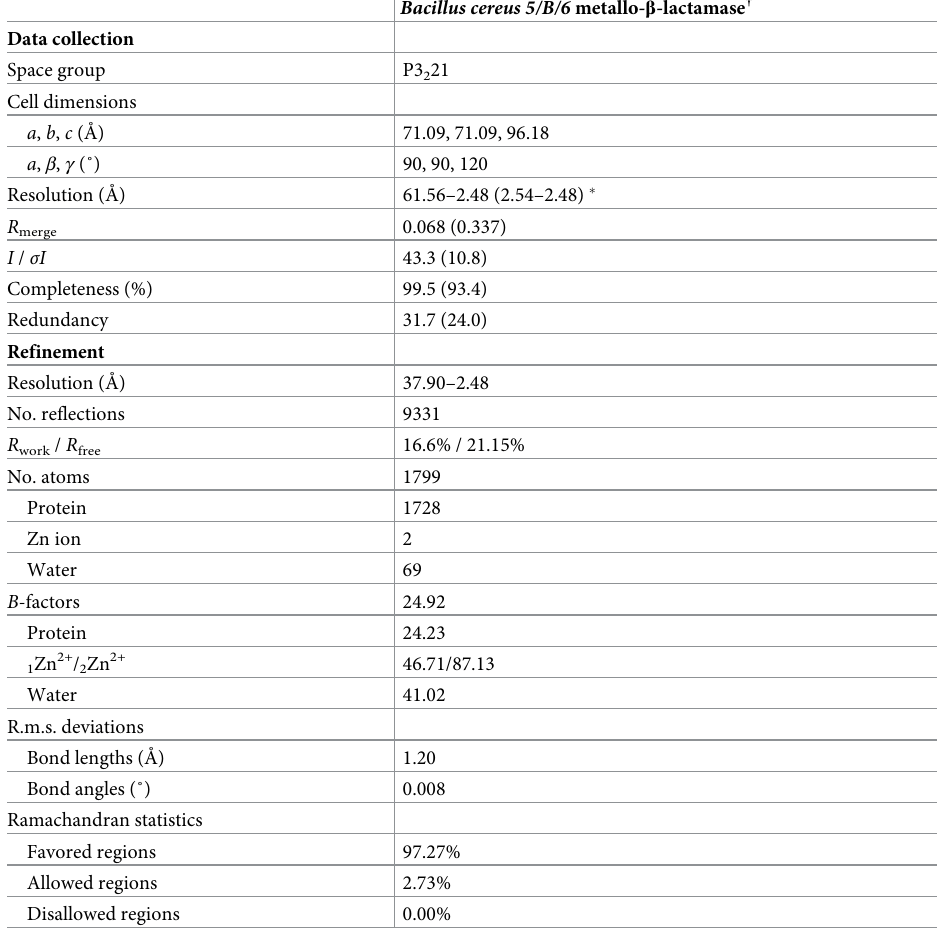
Table 1. Data collection and refinement statistics (molecular